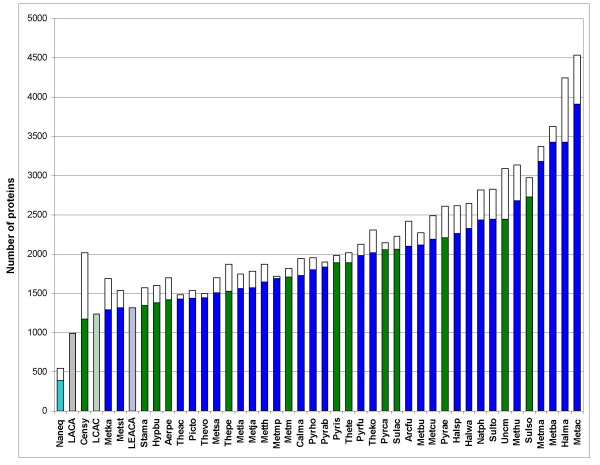
Low-bound reconstructions for ancestral archaeal forms: genomes close in size to modern hyperthermophiles. Each column shows the total number of annotated protein-coding genes in the respective archaeal species; the colored portions (green for Crenarchaeota, blue for Euryarchaeota, and cyan for Nanoarchaeota) show genes included in arCOGs. The hatched columns show the number of arCOGs assigned to LACA, the Last CrenArchaeal Common Ancestor (LCACA) and the Last EuryArchaeal Common Ancestor (LEACA).